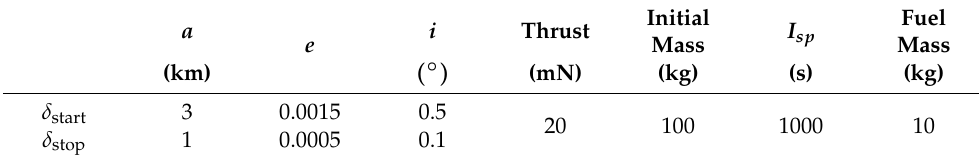
Table 2. Parameters of the Lunar spacecraft, δ start and δ stop .